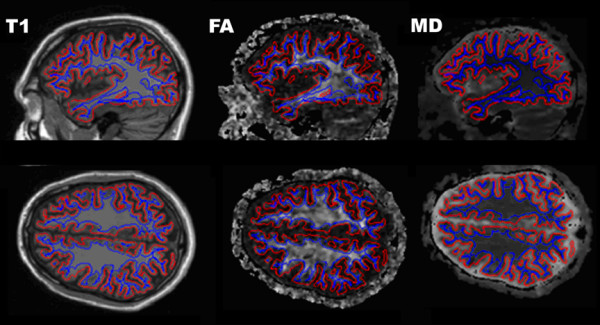
Quantification of tissue properties in the cerebral cortex and in pericortical white matter. Two surfaces were defined from the T1-weighted anatomical images (left column): in mid-gray matter (red) and 2 mm below the gray-white matter boundary (blue). White matter fractional anisotropy (middle) was quantified 2-mm below the gray/white boundary and mean diffusivity (right) was quantified in both the cortical gray matter and the white matter surfaces. Parasagittal (left hemisphere) and axial (above the lateral ventricles) cross-sections from the TBI patient's first imaging session are shown. High intensity regions on the FA map correspond to major fiber bundles running parallel to the cortical surface. Cerebrospinal fluid surrounding the cortex appears bright on the MD map.